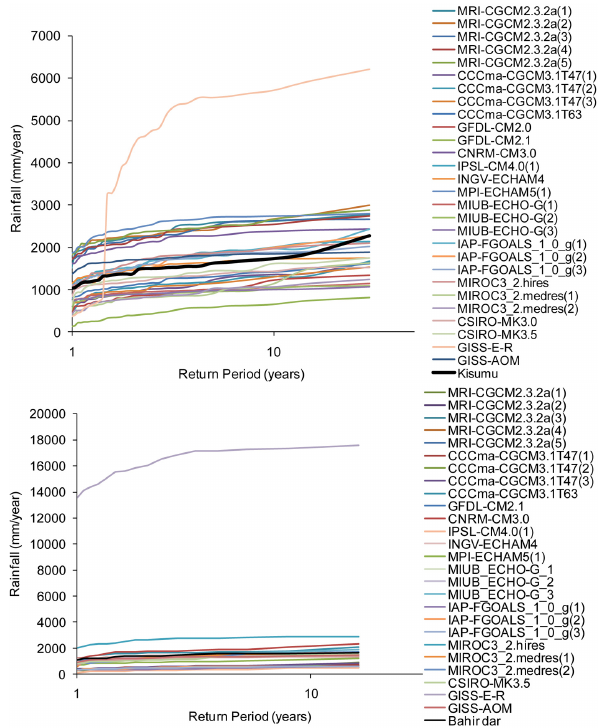
Fig. 7. Return period of annual rainfall quantiles: comparison of GCM results over Nyando (top) and Lake Tana (bottom) catch- ments with observations at Kisumu and Bahir dar, for control period (1971–1990) and (1991–2000)